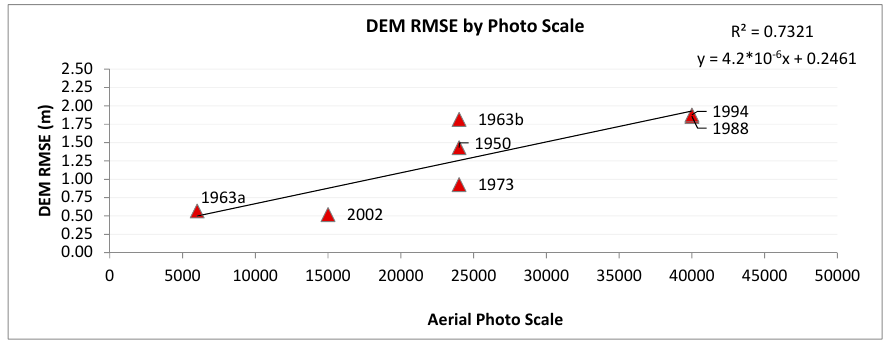
Figure 6. Scatterplot of accuracy values (RMSE in m) and aerial photo scales.